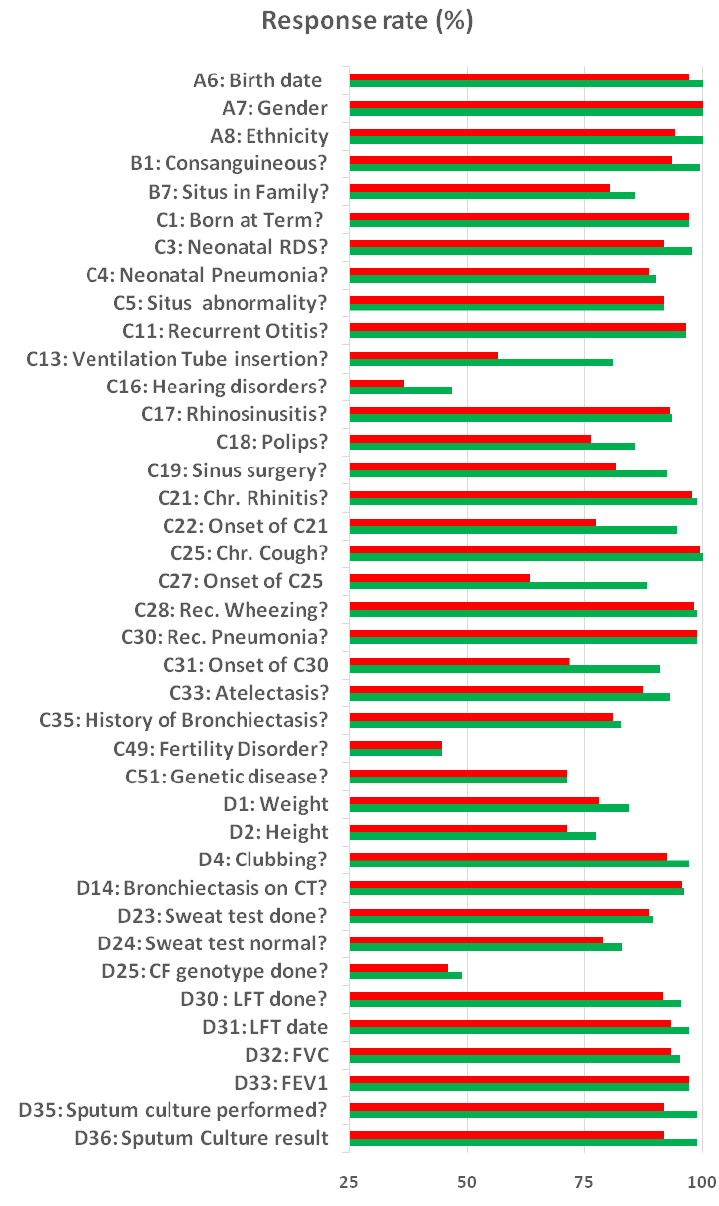
Figure 1. Changes in response rate (%) between initial completion (red columns) and following reminders (green columns) for selected questions. All questions ending with a (?) had yes/no/unknown answers. The rest had free text answers (e.g. birth date). A, B, C and D are the questionnaire sections. Abbreviations: NRDS-Neonatal Respiratory Distress Syndrome; LFT- Lung Function Test; FVC- Forced Vital Capacity; FEV1-Forced Expiratory Volume at 1 st second; CT- Computed Tomography; CF- Cystic